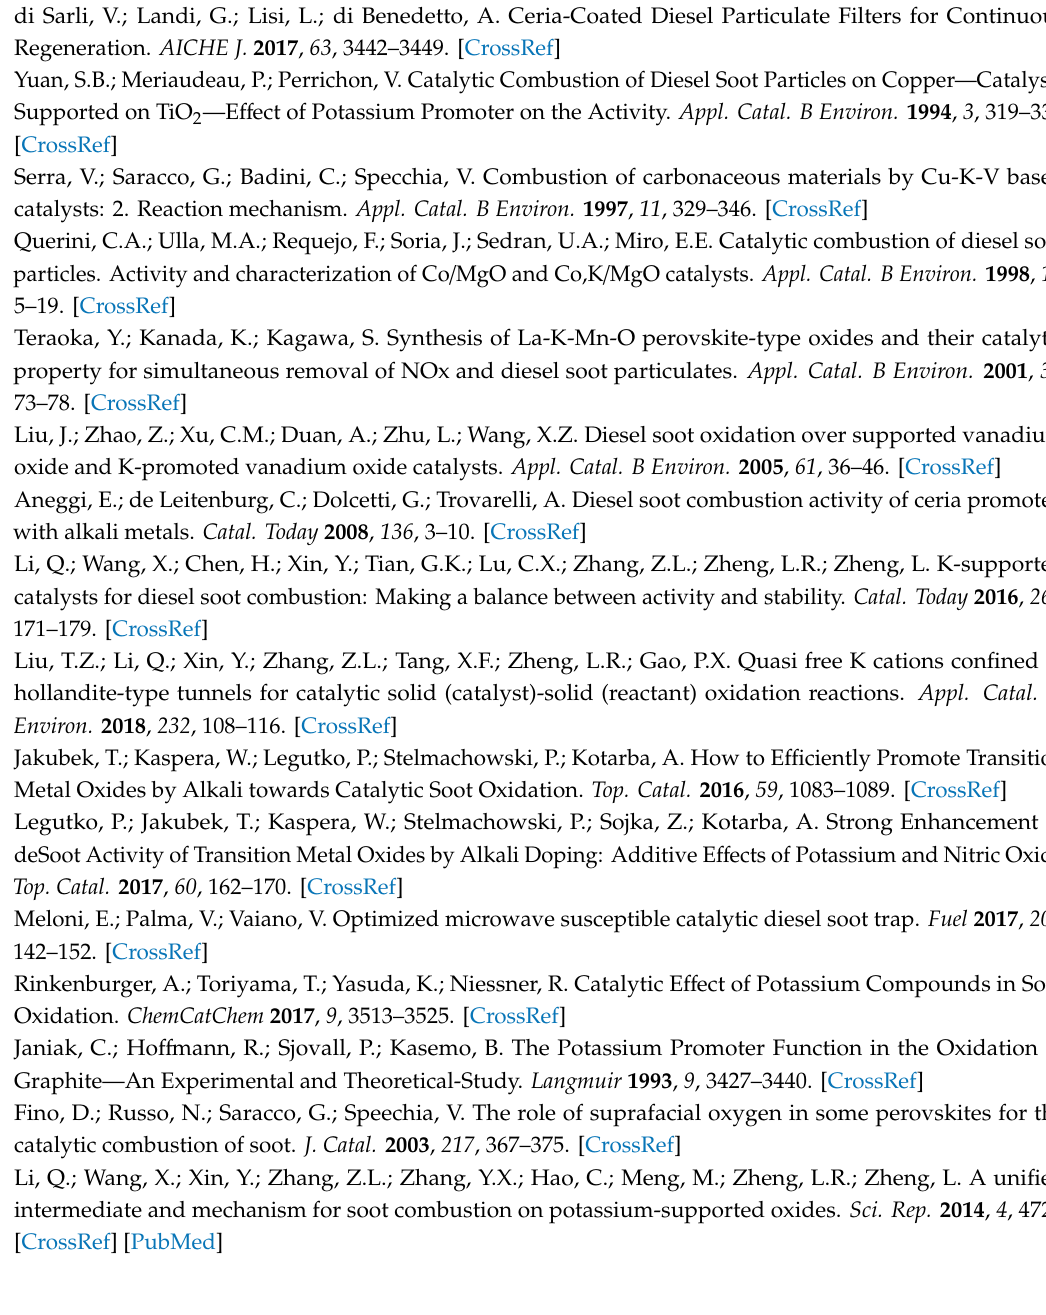
Table S1. EDS Measured Composition of KCeSZ-1 Glass Surface after 2 h Hydrothermal Exposures at Various